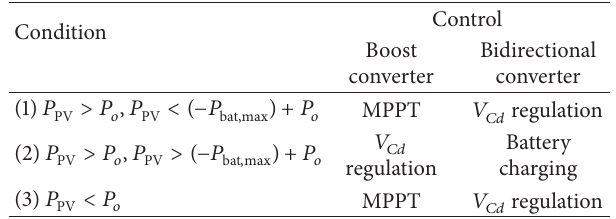
Table 1: Operation condition in islanding mode.